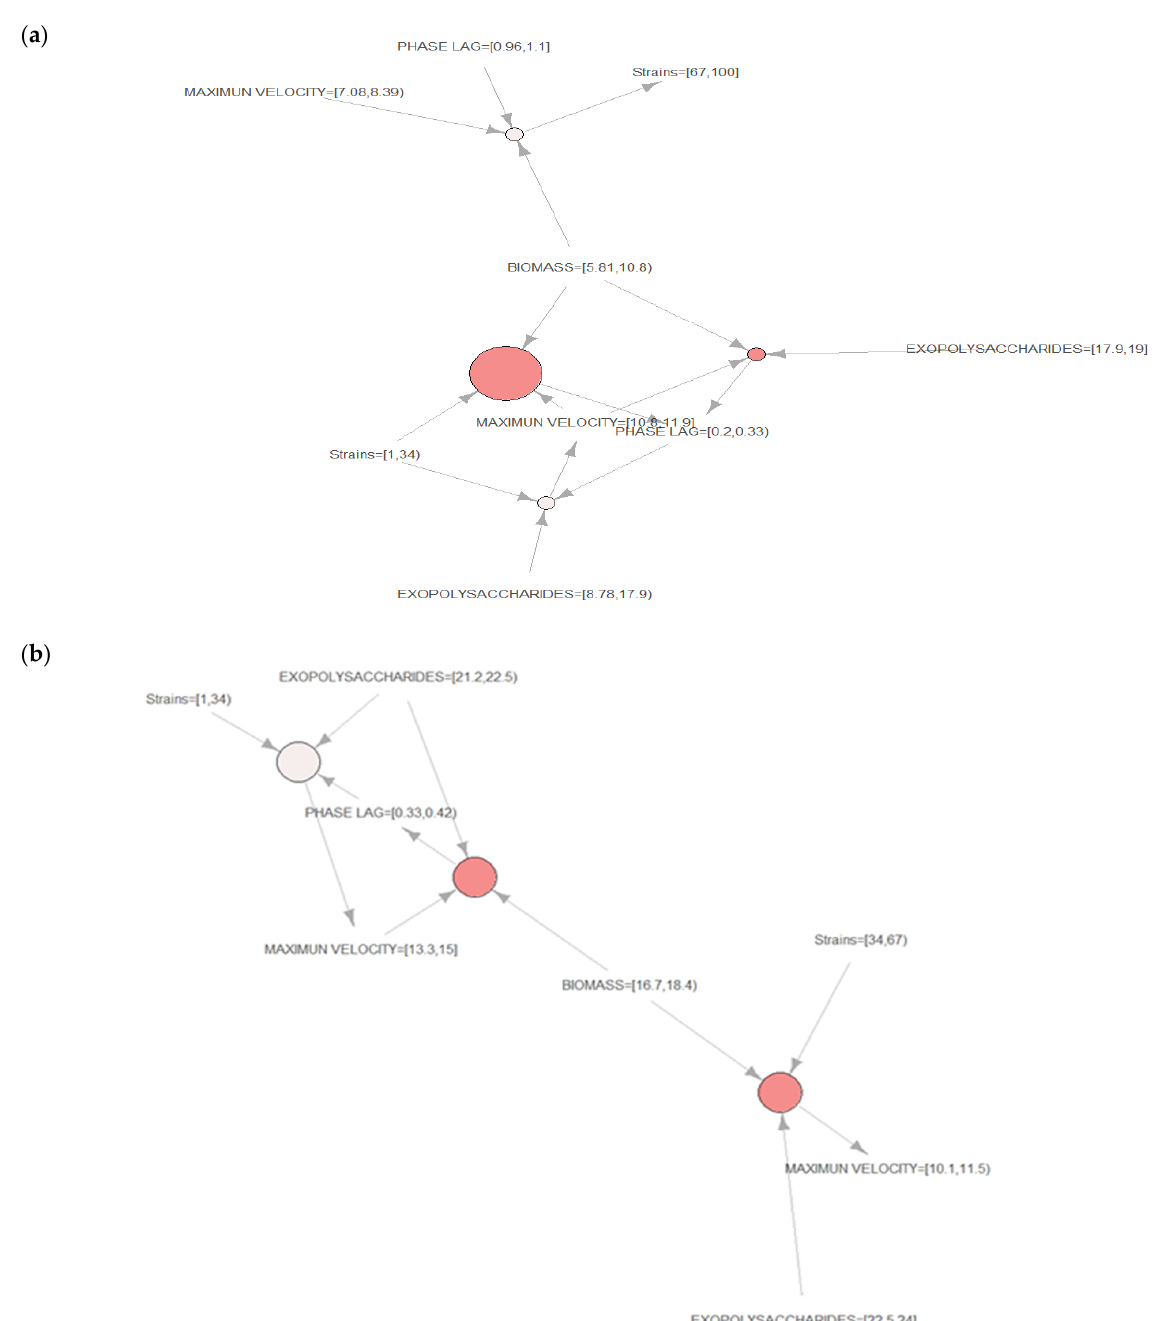
Figure 2. ( a ) Association rules algorithm for mycelial and cultural characteristics of hybrid strains of Pleurotus ostreatus cultivated on solid culture M1 and M2, and liquid culture L1 and L2, ( b ) Association rules algorithm for mycelial and cultural characteristics of hybrid strains of Pleurotus djamor cultivated on solid culture M1 and M2, and liquid culture L1 and L2.